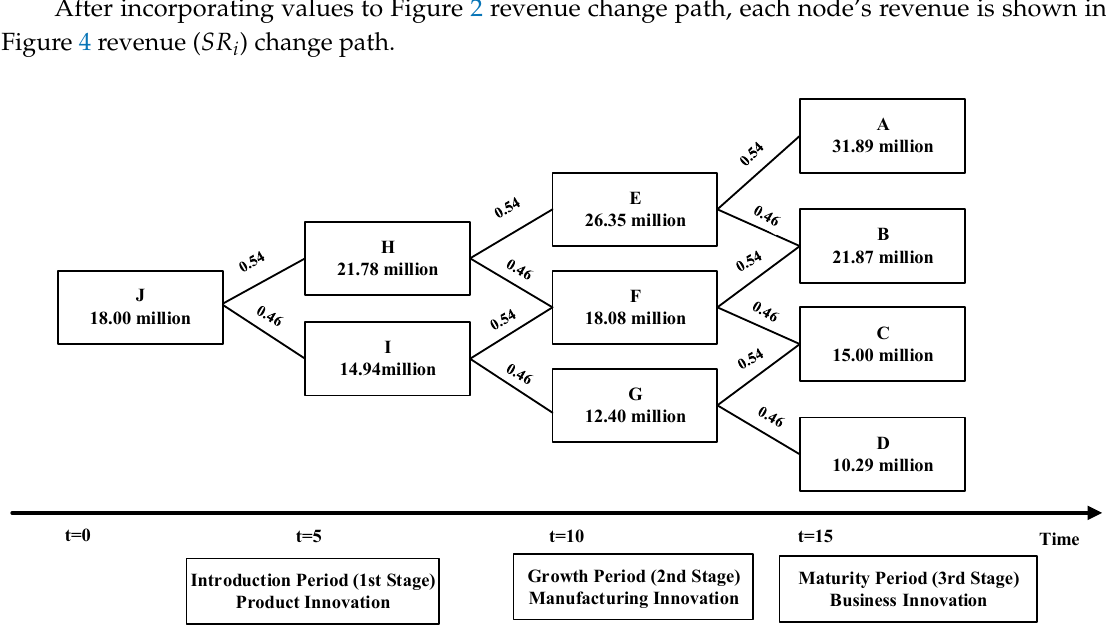
Figure 5. Revenue s i SR value of each node of compound binomial options ( 0.68% r 